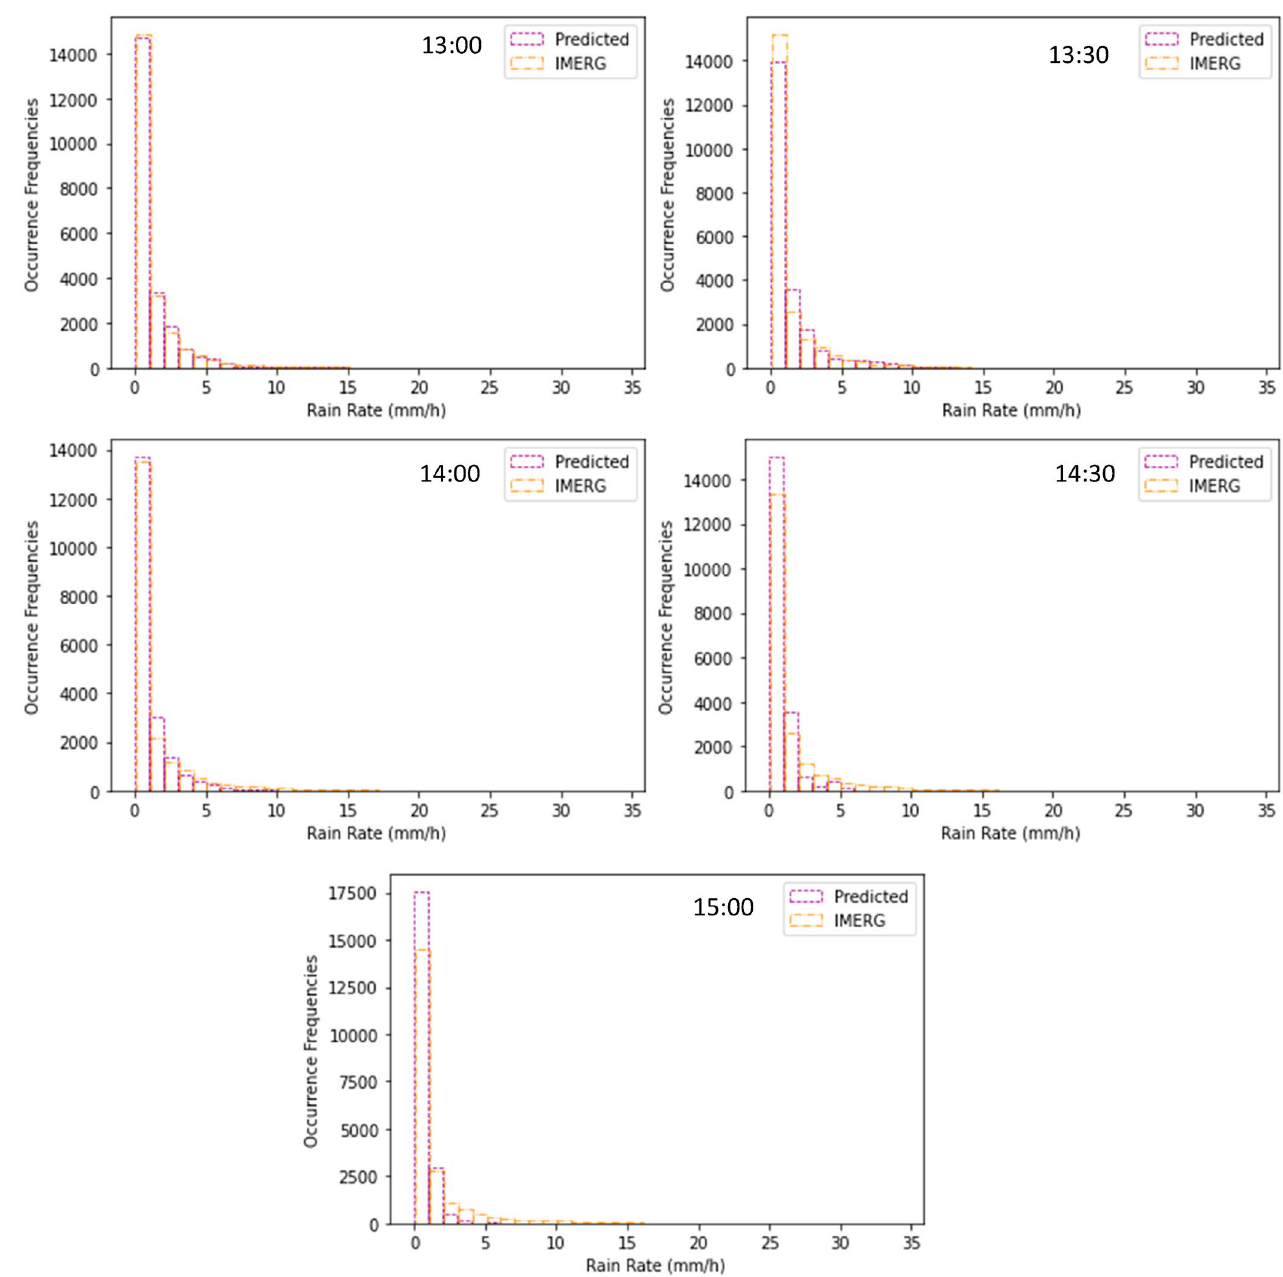
Figure 7. Frequency histogram of predicted and IMERG data.